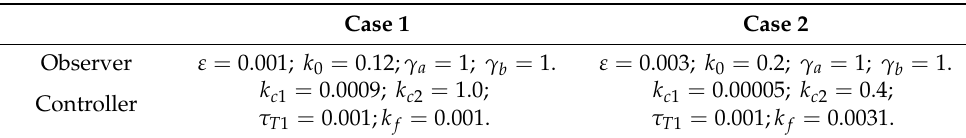
Table 1. Chosen parameter values for the observer and controller.